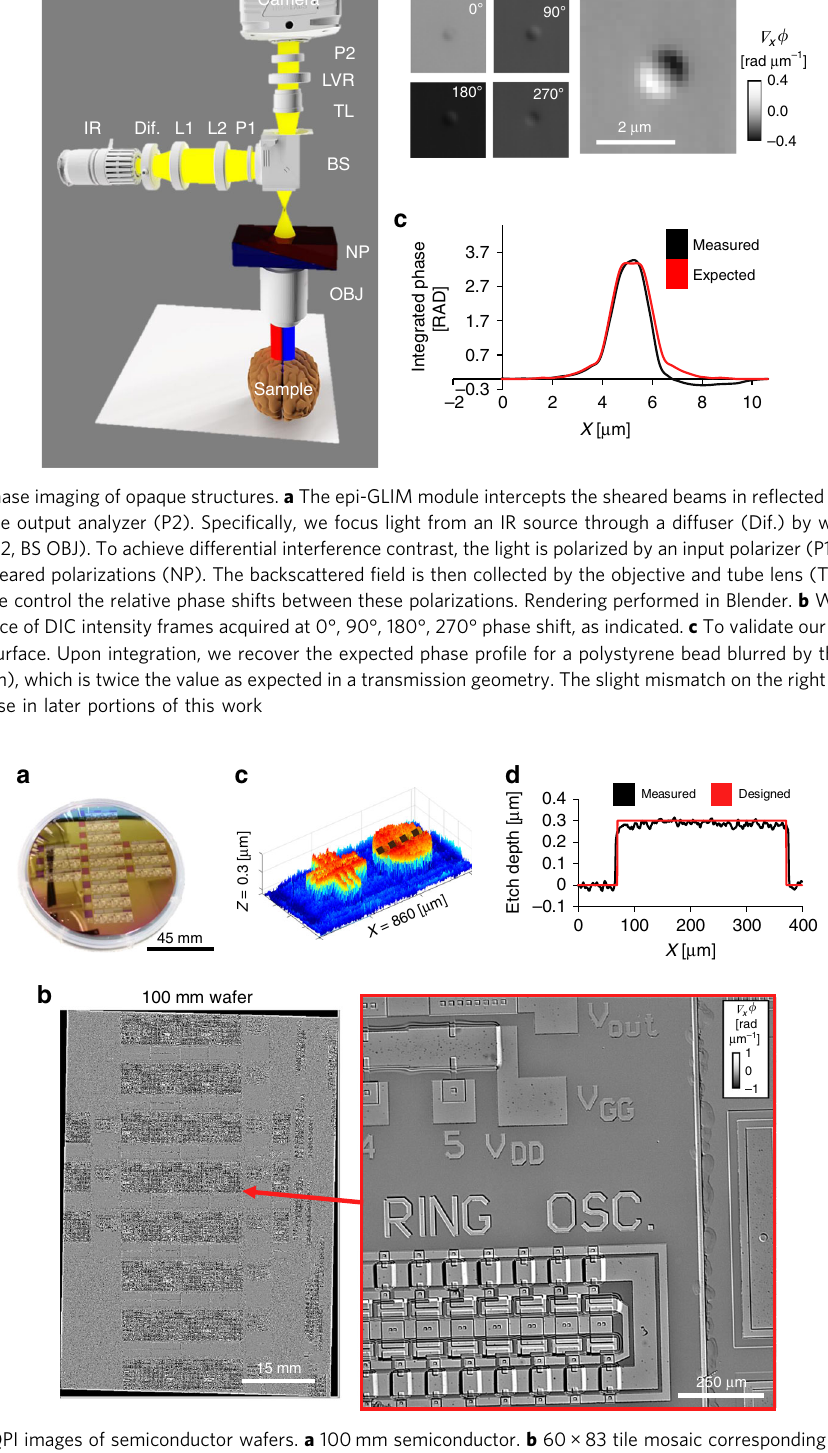
Fig. 2 Epi-GLIM enables QPI images of semiconductor wafers. a 100 mm semiconductor. b 60 × 83 tile mosaic corresponding to a scan range of 45cm 2 , imaged with a ×10/0.3NA objective. c We can measure the system ’ s impulse response by using a known region of the sample to recover a topographic (integrated) phase map at a different location. d After reconstruction, the resulting phase map (large capacitor structures shown) matches well the expected